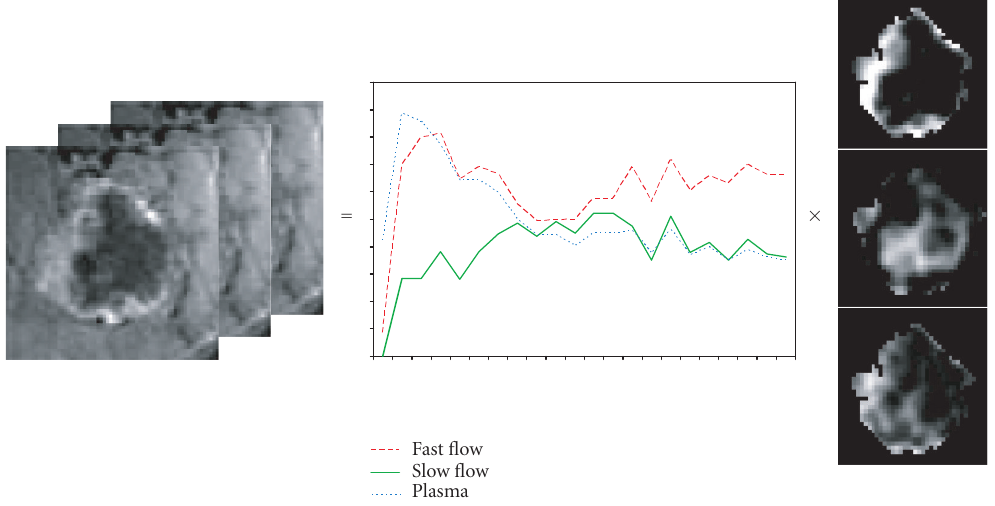
Figure 6: Compartmental latent variable modeling by CCA including plasma input. The source images are given in the right column (from top to bottom: fast flow, slow flow, and plasma